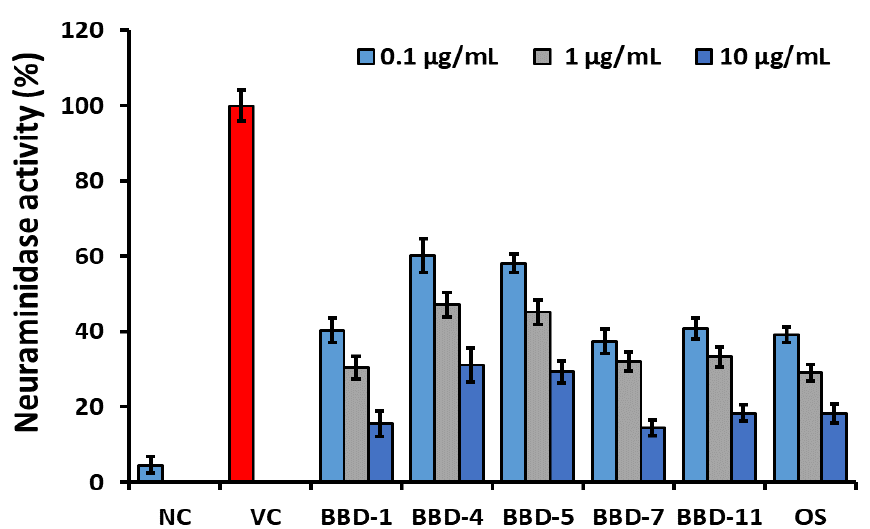
Figure 1. Neuraminidase activity of berberine derivatives comparing with oseltamivir. NC: Negative control. VC: Virus control. OS: Oseltamivir. The error bars are the mean of standard deviation in triplicate.